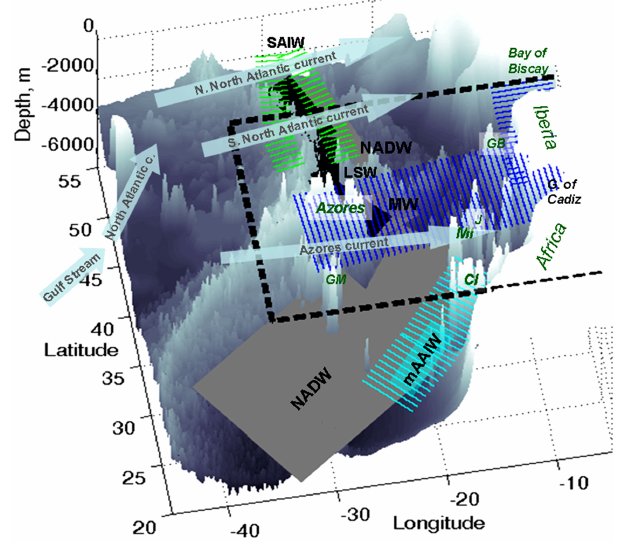
Figure 1. Bathymetry and distributions of the main water types be- low the main thermocline (MW – blue, SAIW – green, mAAIW – cyan, LSW – black, NADW u – grey). The study region is demar- cated by the black dashed lines. Intersections of the black dashed lines with the water types represent the areas where water types enter into the study region. The main thermocline water types, gen- erated in the western Atlantic, enter the study region with the sur- face currents marked with semi-transparent arrows. CI are Canary Islands, MI – Madeira Island, GM – Great Meteor Seamount, J – Josephine Seamount, GB – Galicia